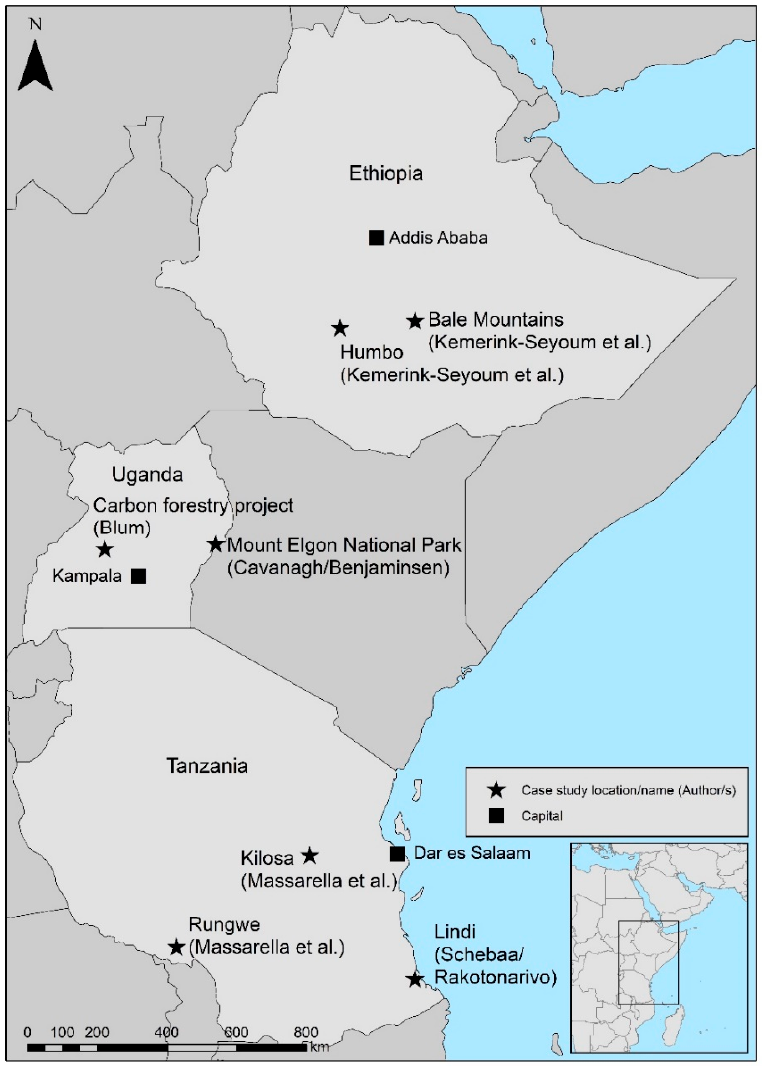
Figure 2. Location of case studies in East Africa (Syed Zulfiqar Ali Shah for the authors, based on [25–27,29,37] ).